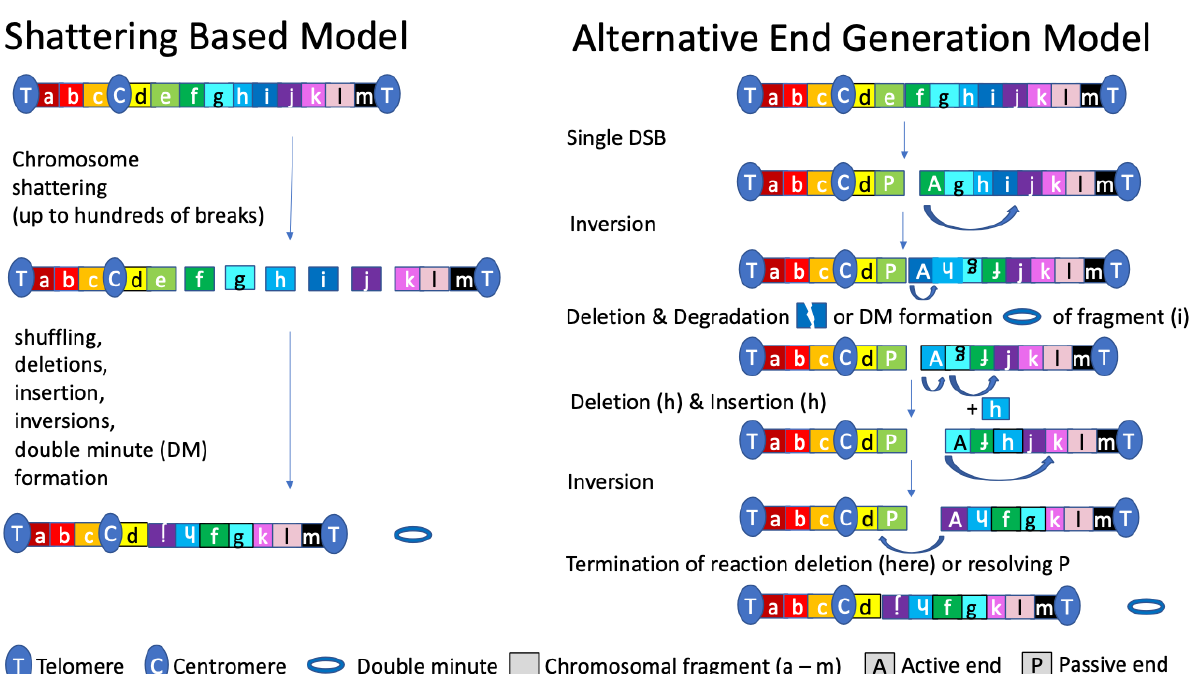
Figure 2. Modeling Chromothripsis: Shattering versus Consecutive Rearrangements. Schematic overview of consecutive AEG reactions leading to multiple different types of rearrangements and the comparison with a shattering-based model. In the shattering model, numerous DSBs are required to enable chromothripsis. In contrast, the AEG model proposes that a single DSB—here, between region e and f—generates a repair-blocking passive end (P) and an intact, i.e., active (A), DNA end. Because the P end blocks DSB repair, the A end is recombined preferentially with proximal accessible elements. This process, which can be associated with deletions, insertions, inversions, and double-minute formation, generates an alternative active end sustaining the domino effect. This cat- astrophic recombination process stops when the P end is resolved or deleted. While both chromo- somal shattering and AEG result in the same chromothripsis product, this viewpoint likes to con- sider AEG as a model for chromothripsis.